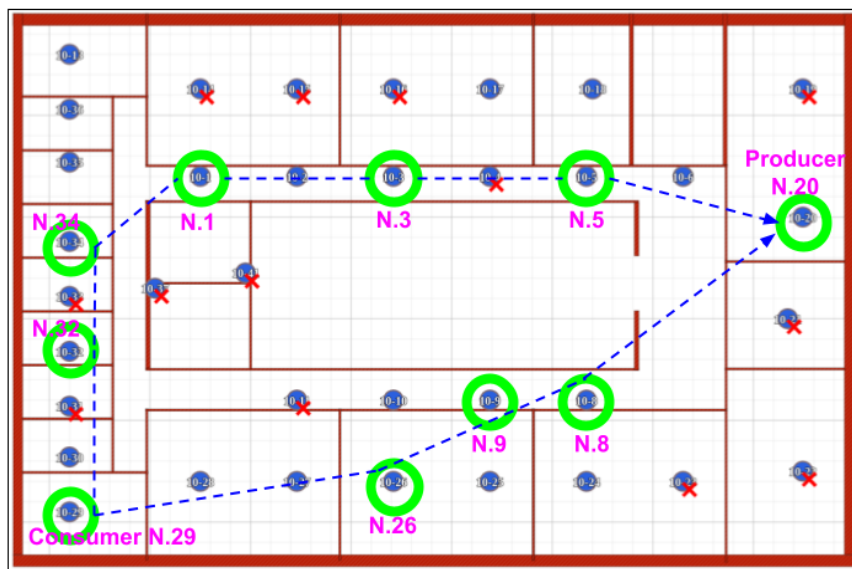
Figure 9. Selected topology—w-iLab.1 office lab 10th floor [38].